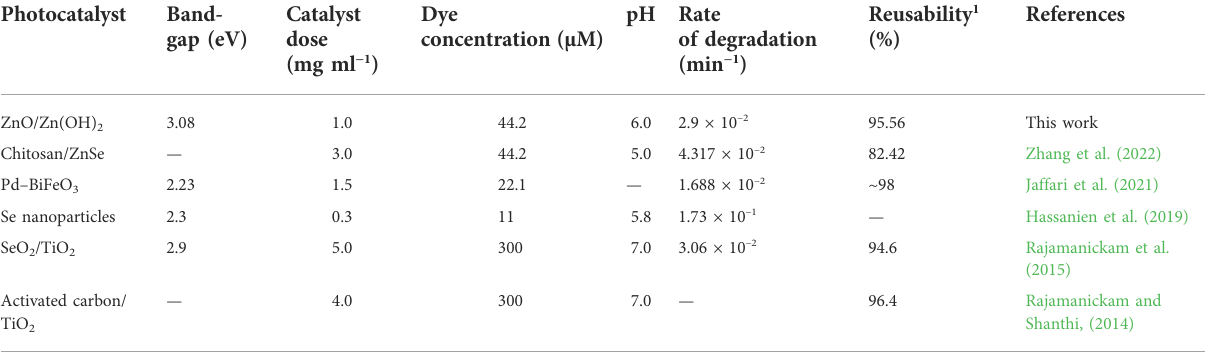
TABLE 1 A comparison of the photodegradation of sunset yellow by various nanostructured photocatalysts.